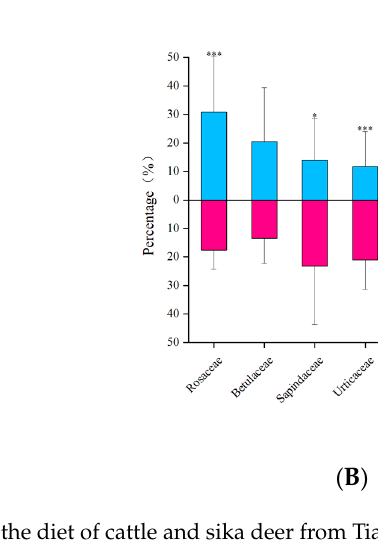
Figure 4. ( A ) NMDS of RRA-based Bray–Curtis dissimilarity of samples from Tiangen (stress = 0.19, PERMANOVA pseudo- F 1,70 = 4.67, R 2 = 0.06, p < 0.001), ( B ) NMDS of RRA-based Bray–Curtis dis- similarity of samples from Tsingke (stress = 0.22, PERMANOVA pseudo- F 1,63 = 4.00, R 2 = 0.06, p < 0.01).